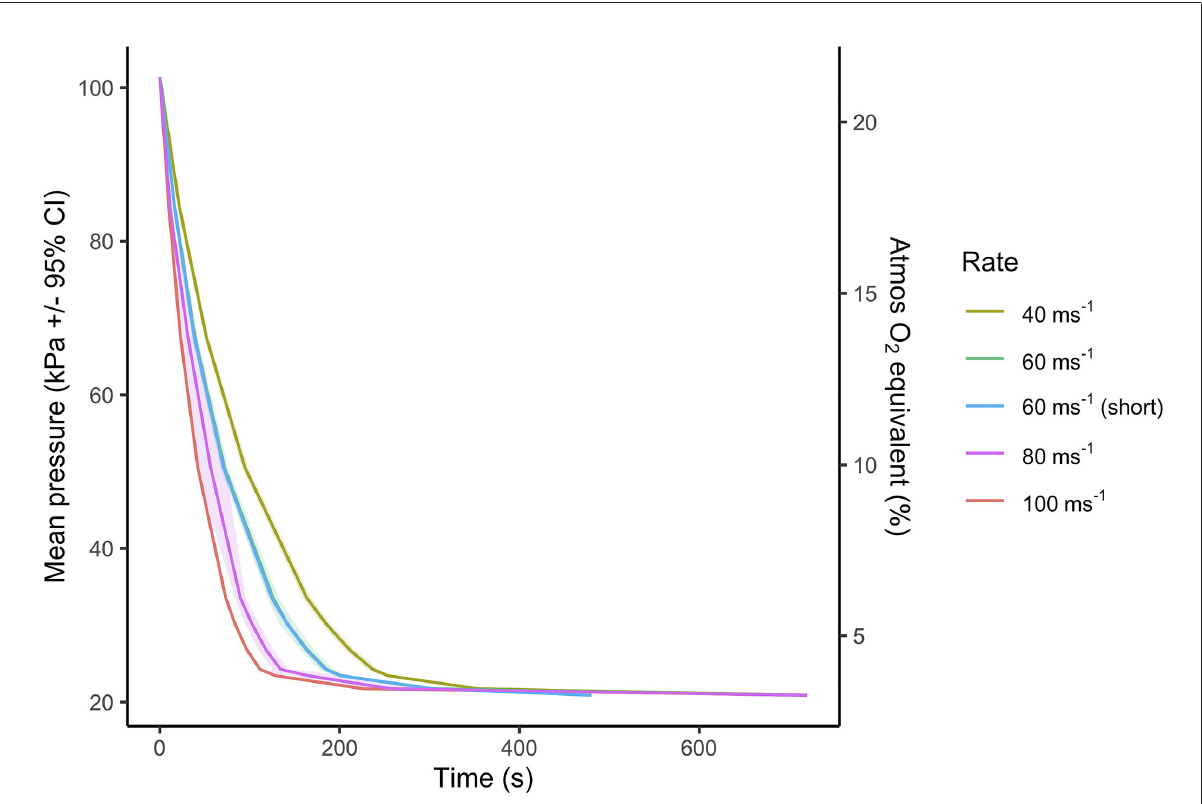
FIGURE2 Mean ± 95% CIs pressure (kPa) over time (s) of the five decompression treatment profiles. Each decompression treatment involved a two-phase process, where in the initial phase the chamber was gradually decompressed according to treatment average rate (40, 60, 80, or 100 ms − 1 ) to a target pressure of 33 kPa ( ∼ 8,459m equivalent altitude) in ∼ 163, ∼ 125, ∼ 90, and ∼ 73s, respectively. Following target pressure being reached, the second phase (hold phase) involved slowing the decompression to the final absolute vacuum of ∼ 20 kPa (equivalent to 11,498m) and maintaining the absolute vacuum to the two fixed cycle lengths of 720s (12min) for all decompression rates and an additional shorter cycle of 480s (8min) for the 60 ms − 1 rate only. A scaled indication of comparable atmospheric oxygen (O 2 ) equivalent as a percentage (%) of inspired